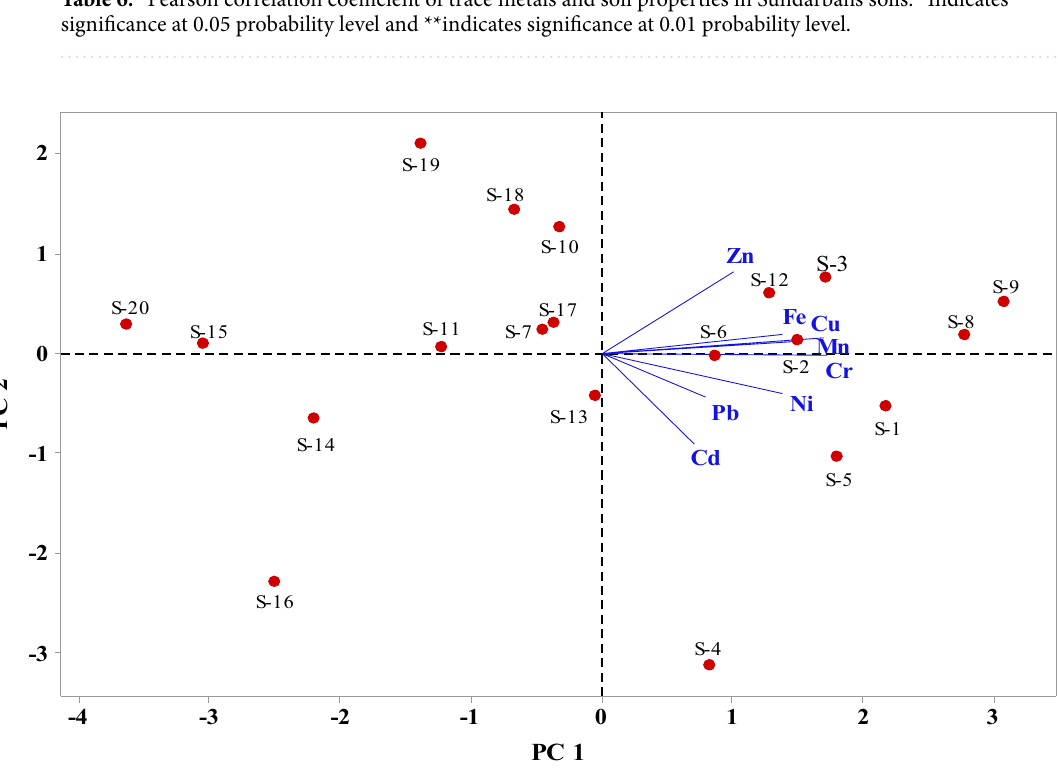
Figure 3. Score plot of studied locations and loading plot of studied trace metals for PC 1 and PC